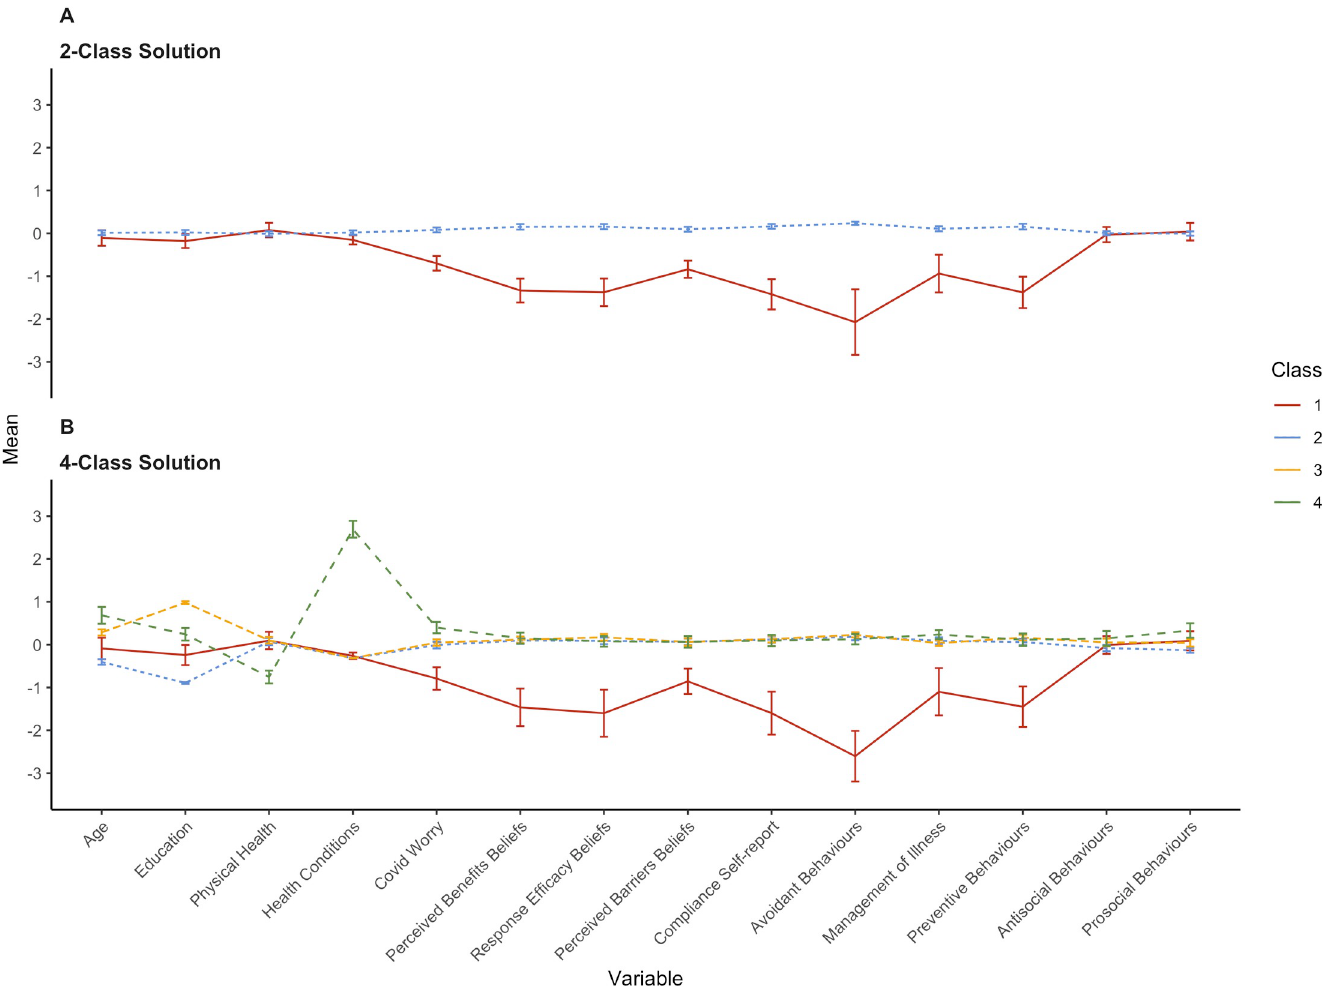
Fig 1. Latent profile groups for 2- (A) and 4-class (B) solutions. Error bars represent the standard error of the mean.